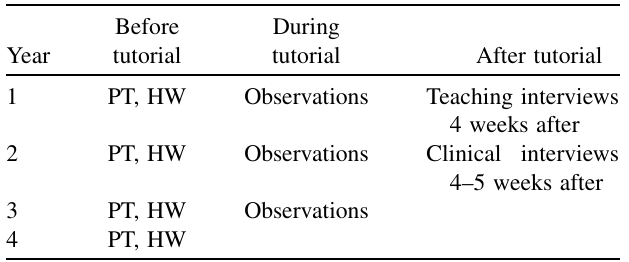
TABLE I. Research time line. An outline of the research activities that took place either before, during, or after tutorial implementation for each year of the study. ‘‘PT’’ refers to the Taylor series pretest, ‘‘HW’’ refers to a pretutorial homework assignment that students completed and used during the tutorial, and ‘‘Observations’’ refers to videotaped classroom